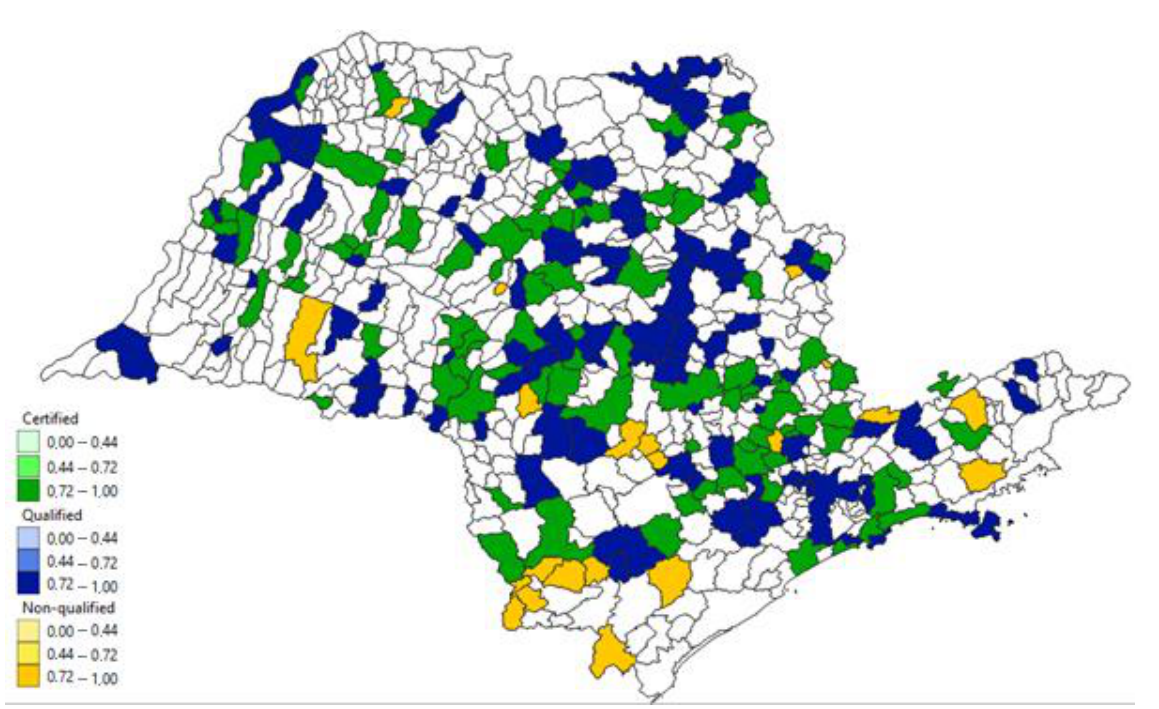
Figure 5. Municipalities in the highest stratification of the Sustainable Human Development Index.